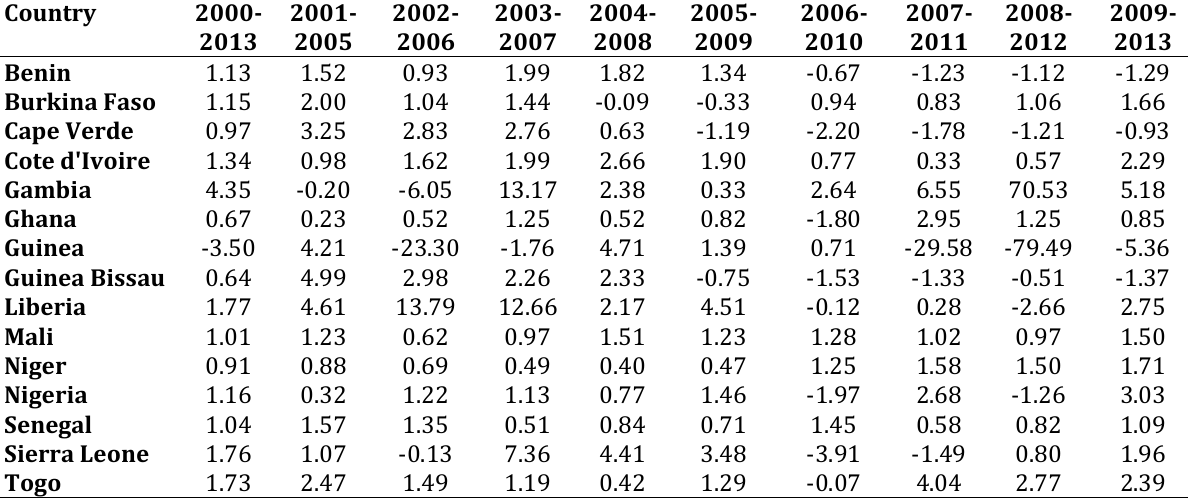
Table 7: Total freight transport elasticity for ECOWAS Sub-Region Country